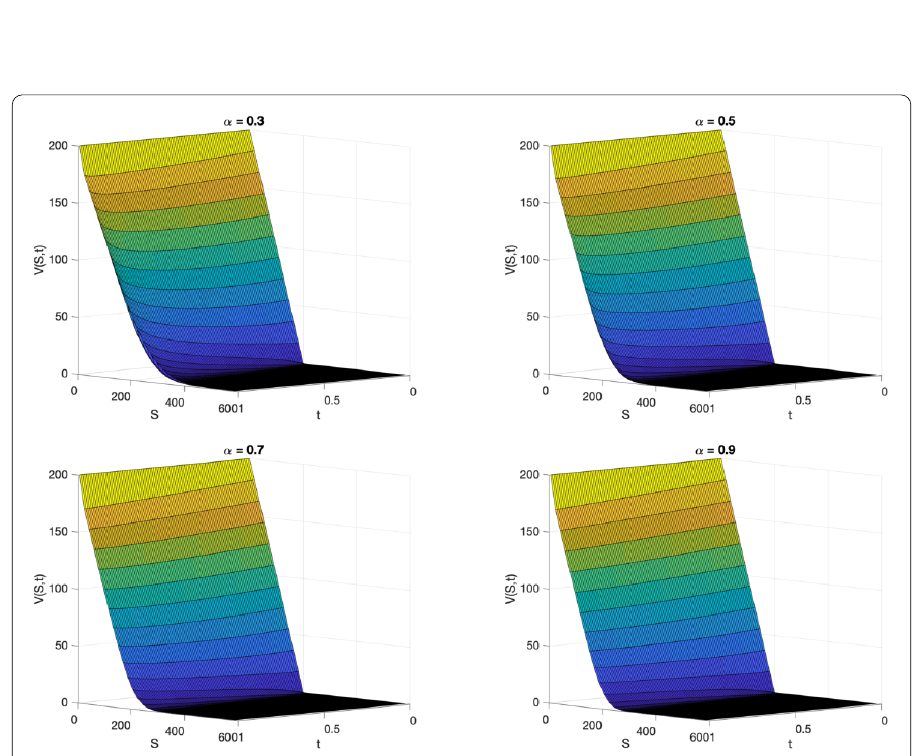
Figure 9 Payoffs under Example 5.2 for α = 0.3,0.5,0.7,0.9; δ = 0.045 for all 0 ≤ t ≤